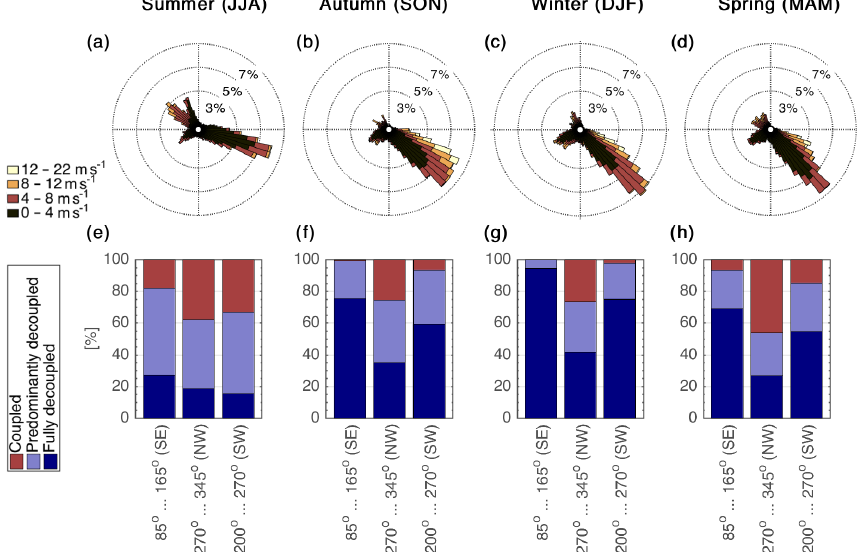
Figure A2. Wind rose for 30min mean 10m wind for each season (a–d) in the cloud observation period (June 2016–October 2018). The fraction of P-MPC cases classified as coupled, predominantly decoupled, and fully decoupled for each surface wind direction mode in each season (e–f)